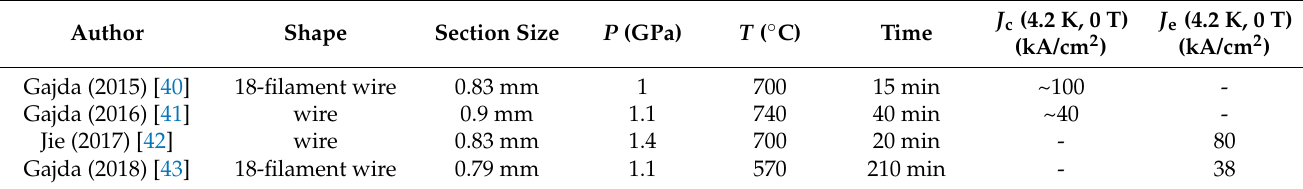
Table 3. Parameters of MgB 2 wires fabricated by the HIP